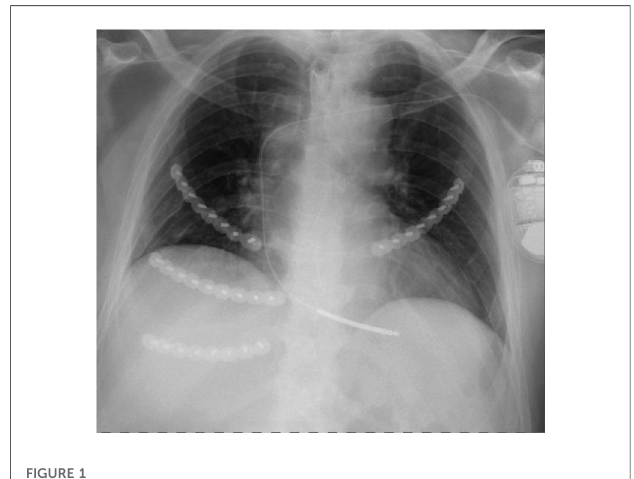
FIGURE 1 Example of bilateral plating of rib fractures sustained during